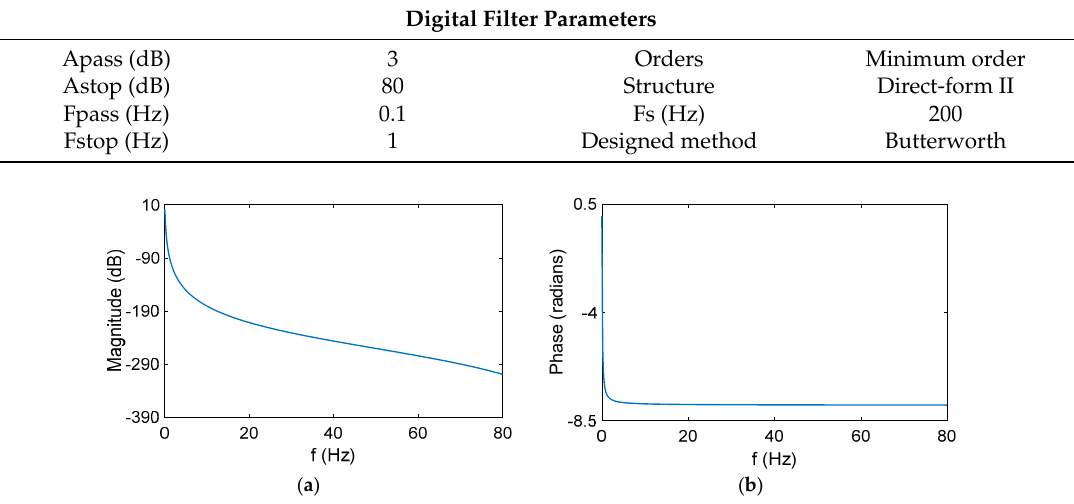
Table 1. The parameters of digital filter.